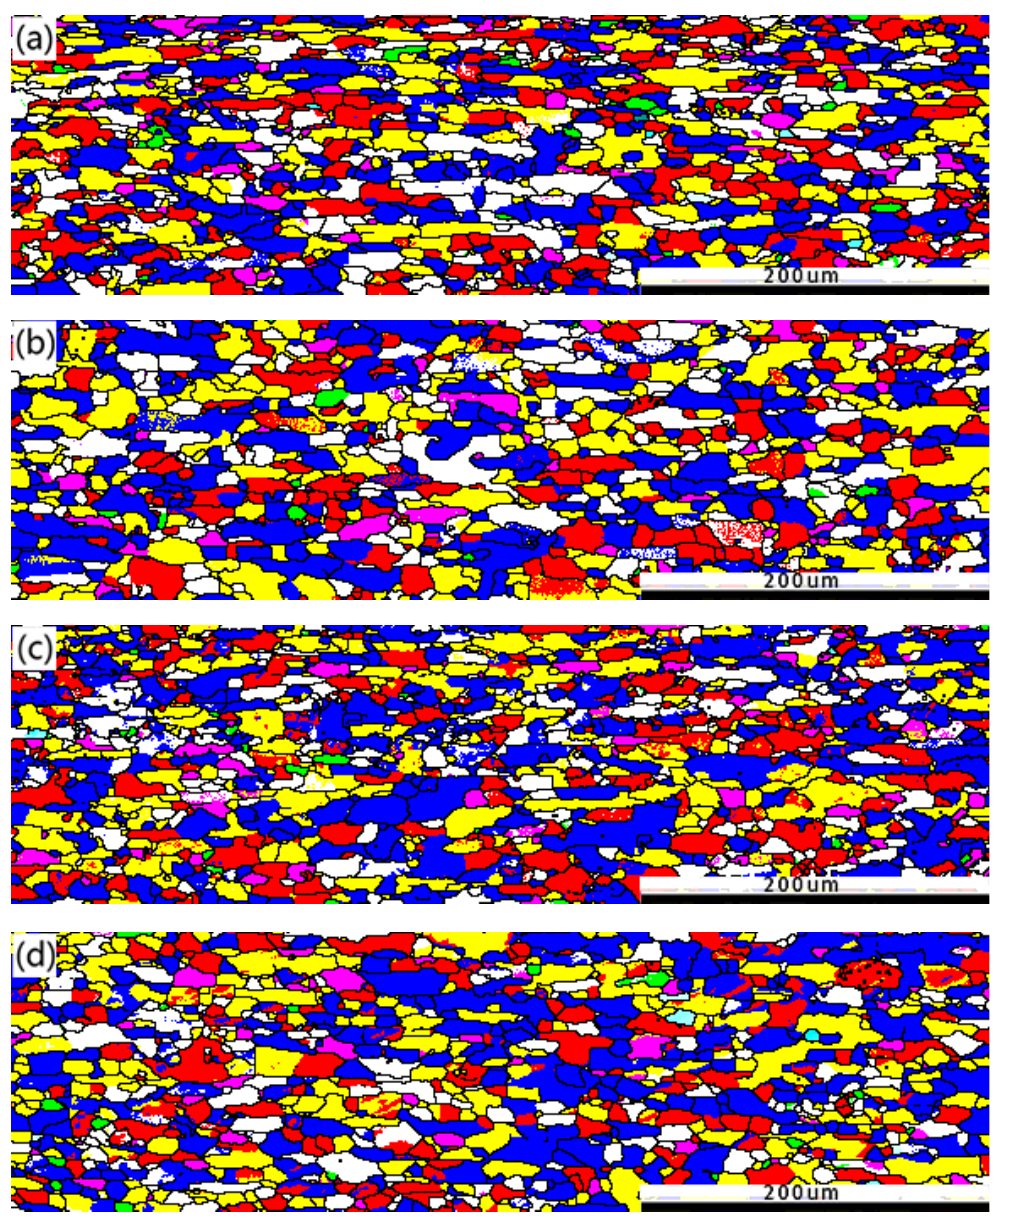
Figure 7. Distribution maps of typical textures at different annealing temperatures. ( a ) 710 °C, ( b ) 730 °C, ( c ) 760 °C and ( d ) 780 °C. Blue represents {111} <112> texture, red represents {111} <110>, yellow represents {112} <110>, purple represents {001} <110> and green represents {001} <001>.